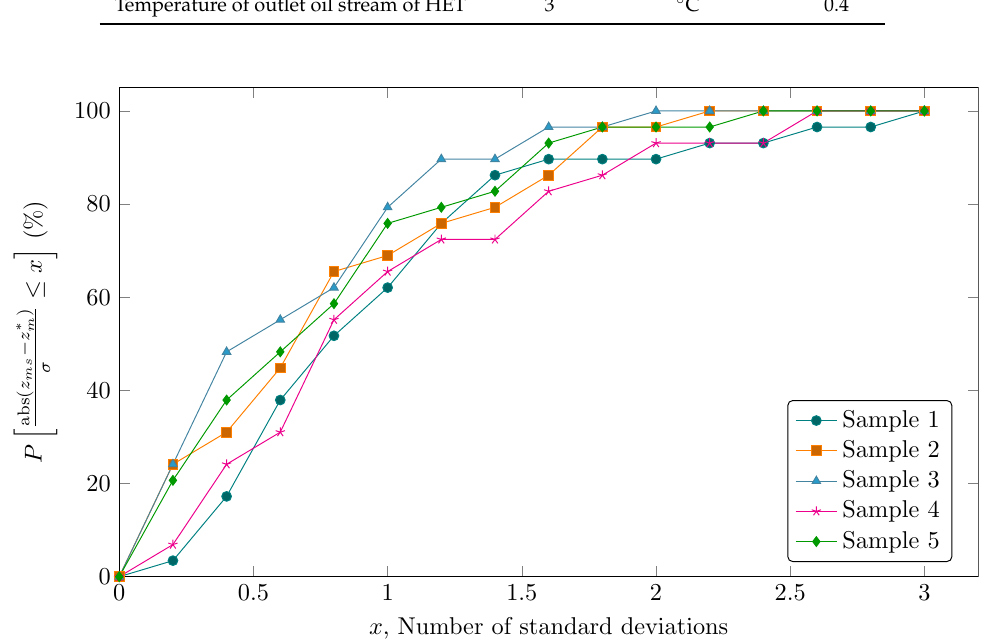
Figure 2. Cumulative distribution function of the variability around the true values for each sample